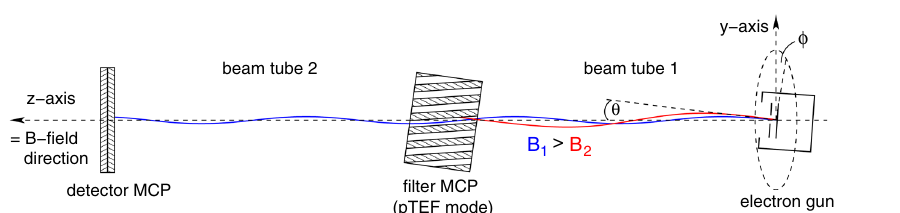
strength B in beam tube 1 is required for the electrons to pass the filter ( B 1 , blue track). Changing the magnetic field changes the phase and thus the angle with which the electrons enter the channels of the filter MCP and causes them to be absorbed in the pTEF mode ( B 2 , red